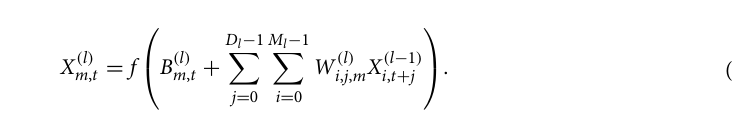
Figure 1. Illustration of the proposed model architecture and deep learning framework. Figure generated in PowerPoint version 1808, https:// www. micro soft.